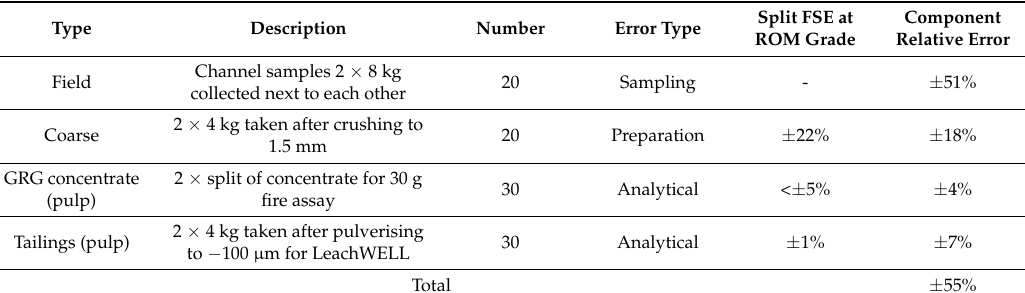
Table 22. Analysis of duplicate sampling